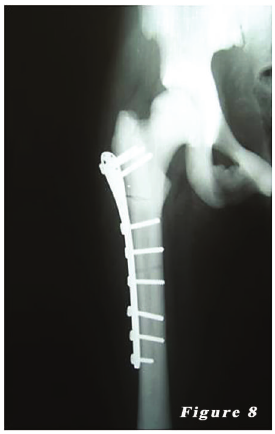
Figure 8: Postoperative right femur radiograph of the second patient.